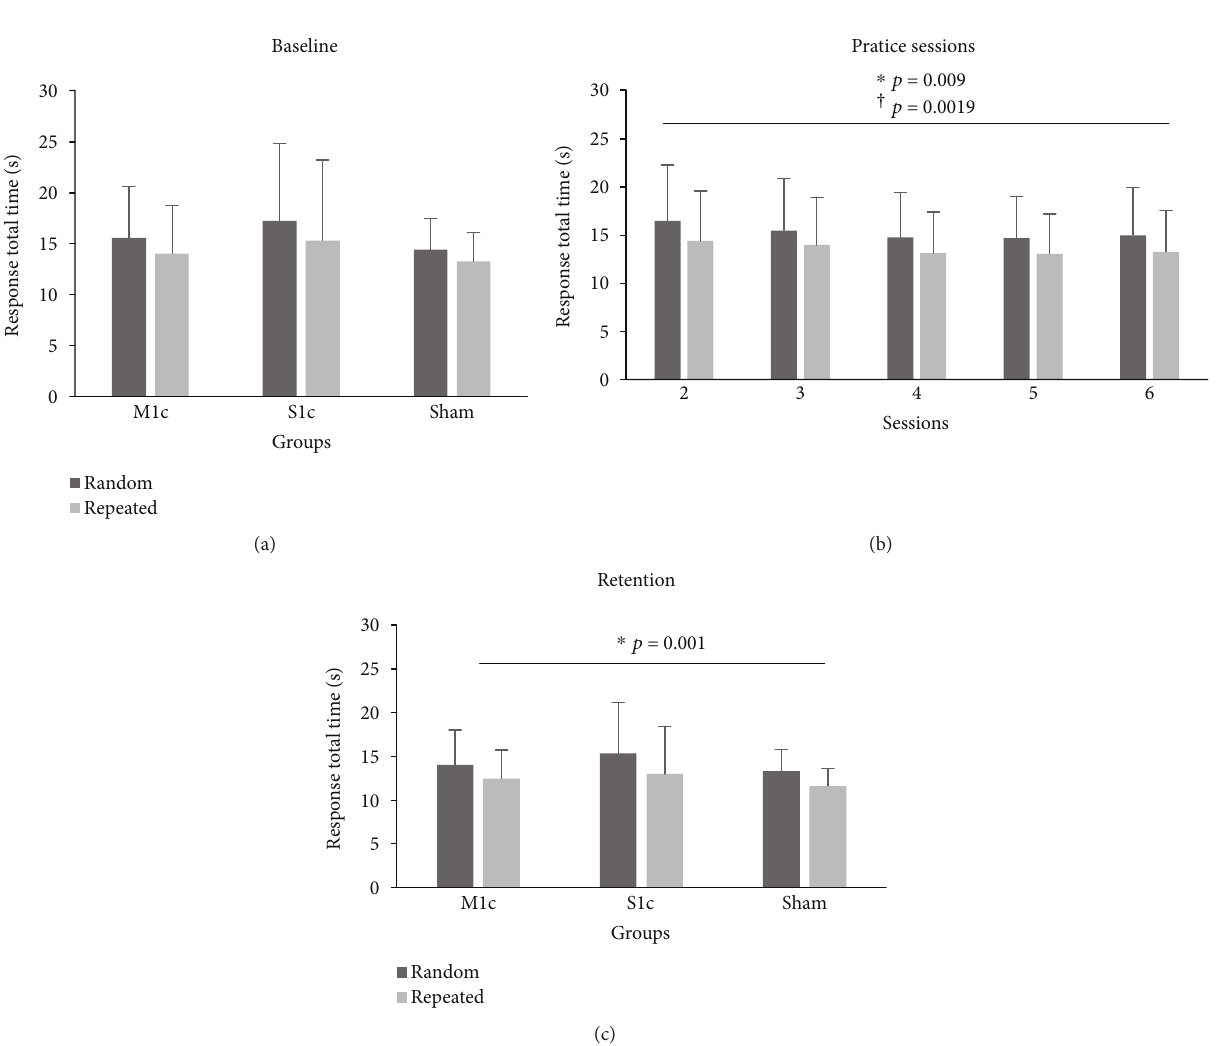
= 29 94 , p < 0 001 . 1,25 = 19 63 , p < 1,23